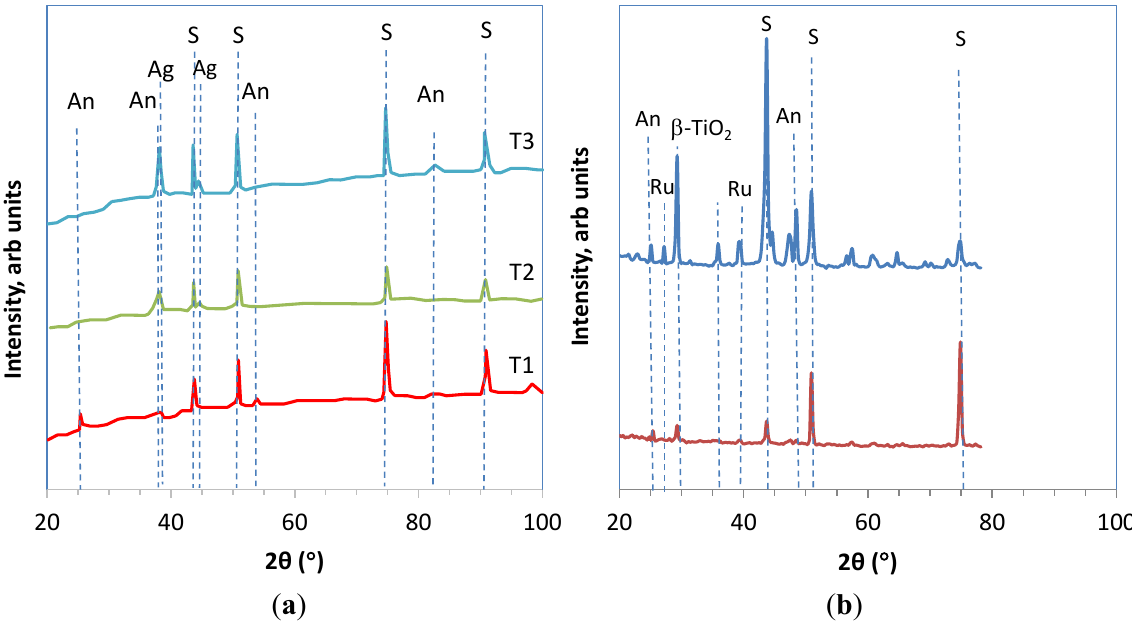
Figure 2. Microstructure of coatings as evaluated using XRD, ( a ) as deposited TiO Ag-TiO coatings (T1–T3 ); and ( b ) TiO 2 U2) (S—substrate, An—anatase,